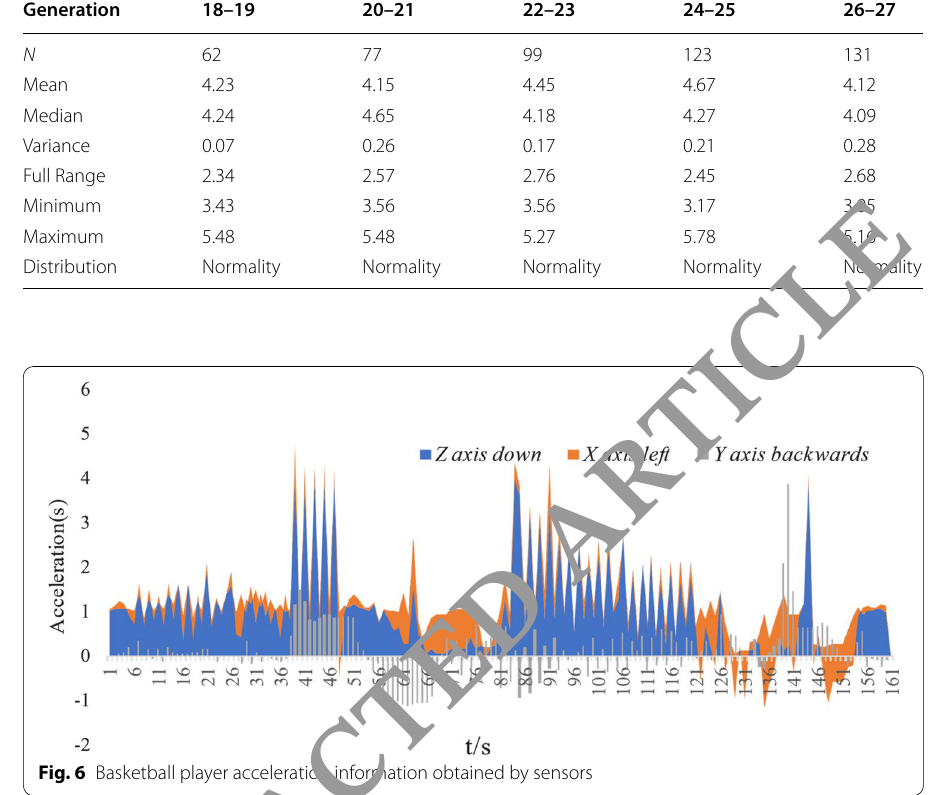
Fig. 6 Basketball player acceleration information obtained by